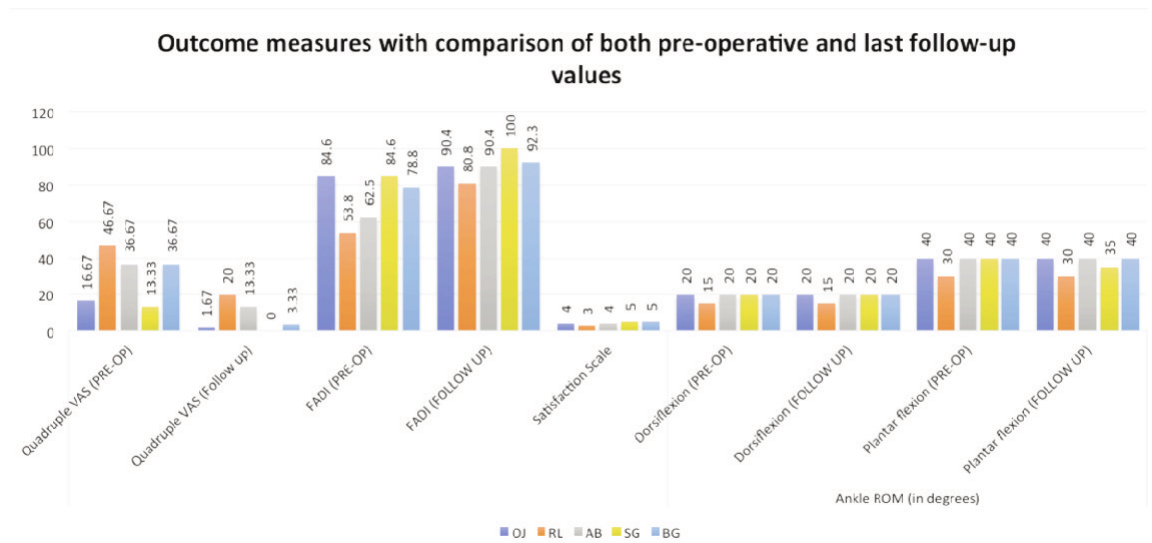
Outcome of the patients based on Foot and Ankle Disability Index (FADI), Ankle Range of Motion (ROM) and Quadruple Visual Fig. 6: Analogue Scale